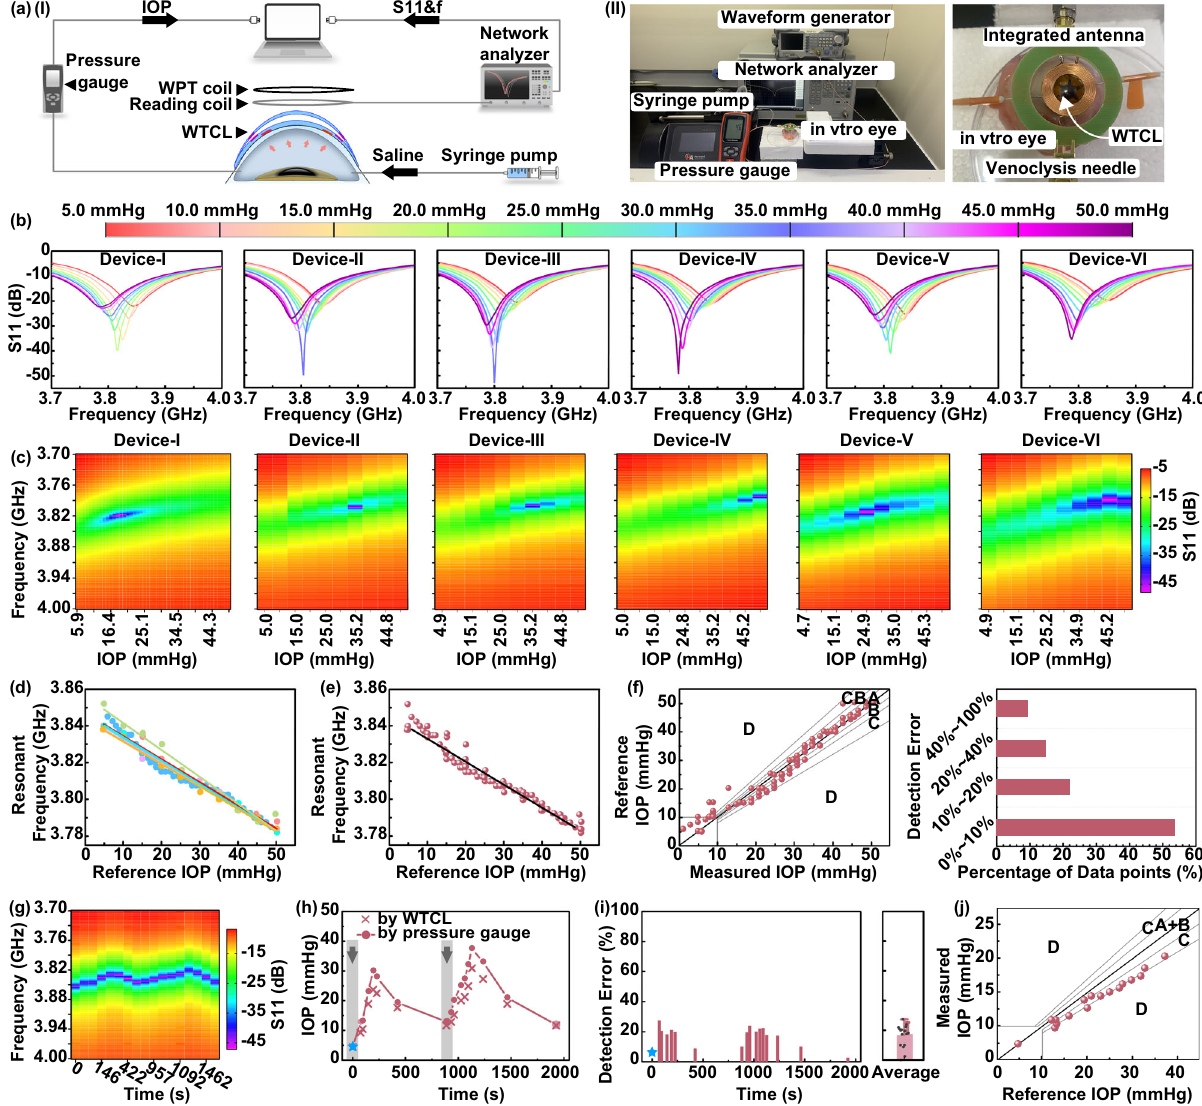
Fig. 3 IOP sensing performance of the WTCL. a (I) Schematic and (II) experimental setup of the wireless IOP sensing experiments. b The re fl ection spectra of six representative WTCL devices worn on porcine eyeball at different IOP. c The results of the S11 values at different frequencies and IOP conditions in ( b ) were plotted as a heatmap diagram, where the value of S11 exhibited a linear pattern in the frequency-IOP heatmap. d Linear regression of resonant frequency versus IOP value of each WTCL device. e The averaged linear regression of resonant frequency versus IOP value of the six WTCL devices in ( b ). f Error grid analysis and statical analysis of the IOP sensing accuracy via WTCL. Region A, B, C, and D referred to errors <10, 10 – 20, 20 – 40, and >40%, respectively. g Heatmap plot of the re fl ection coef fi cients recorded during the continuous recording of IOP via WTCL. h Continuous IOP signals monitored by WTCL on ex vivo porcine eyeball. The calibration point using reference IOP was marked with blue asterisks. The black arrow referred to the time point of saline injections. i Statistical analysis of detection errors via WTCL compared to commercial pressure gauge at different time points. The calibration point was marked with blue asterisks. N = 17 data points. Data were presented as mean ± SD. j Error grid analysis of the continuous IOP sensing via WTCL. Region A + B, C, and D referred to errors <20, 20 – 40, and >40%, respectively. N = 17 data